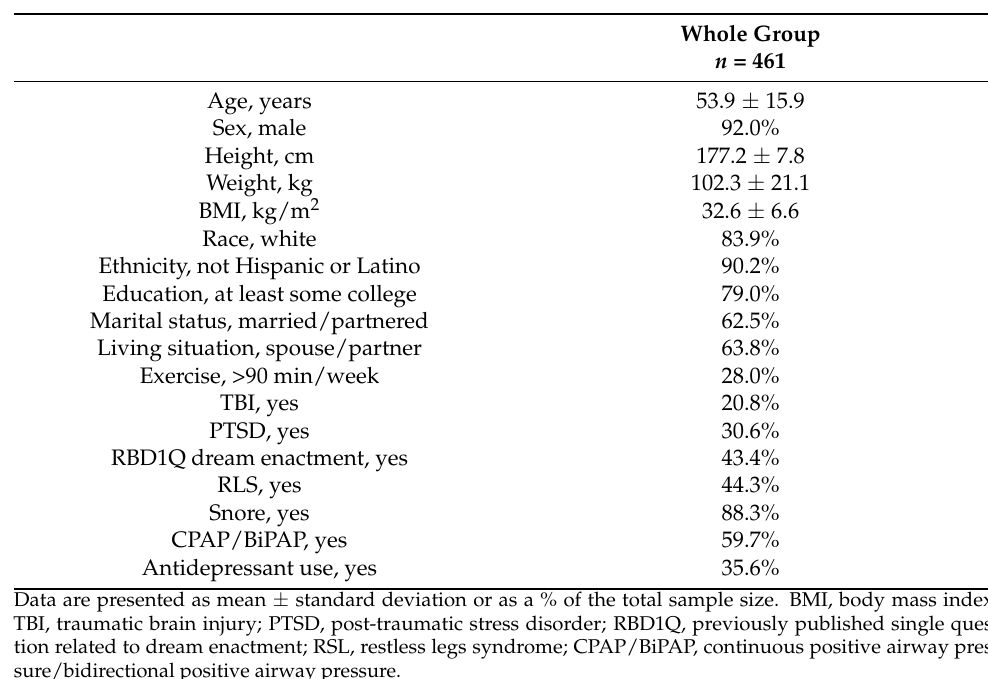
Figure 3. Epoch-based HF:LF analysis : horizontal violin plots (non-truncated/halved) with corre- sponding box-whisker plots illustrating the spread across Group E1 (open plot; average HF:LF in all epochs of REM sleep without REM sleep without atonia), Group E2 (light shaded plot; average HF:LF in every epoch of REM sleep with exactly 1 REM sleep without atonia event), and Group E3 (heavy shaded plot; average HF:LF in every epoch of REM sleep with ≥ 2 REM sleep without atonia events). The heavy solid line corresponds to the median value with the 25th and 75th percentile indicated by the bracketed lines/box outline. Whiskers indicate the 5th and 95th percentiles.